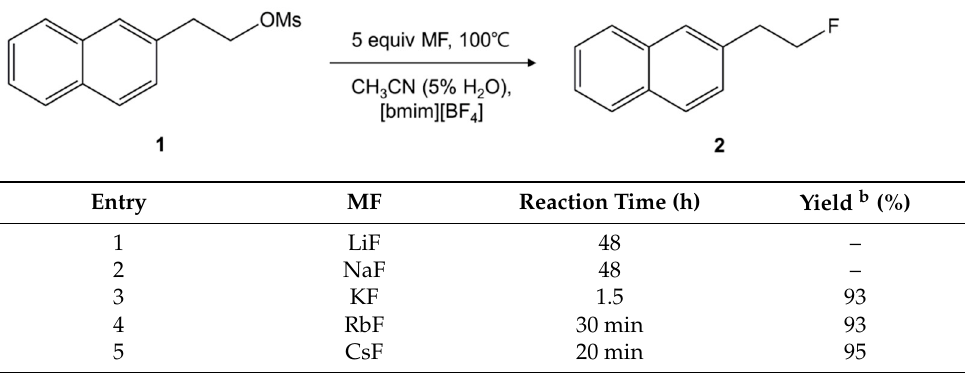
Table 3. Fluorination of mesylate 1 with various metal fluorides in [bmim][BF 4 ] a .